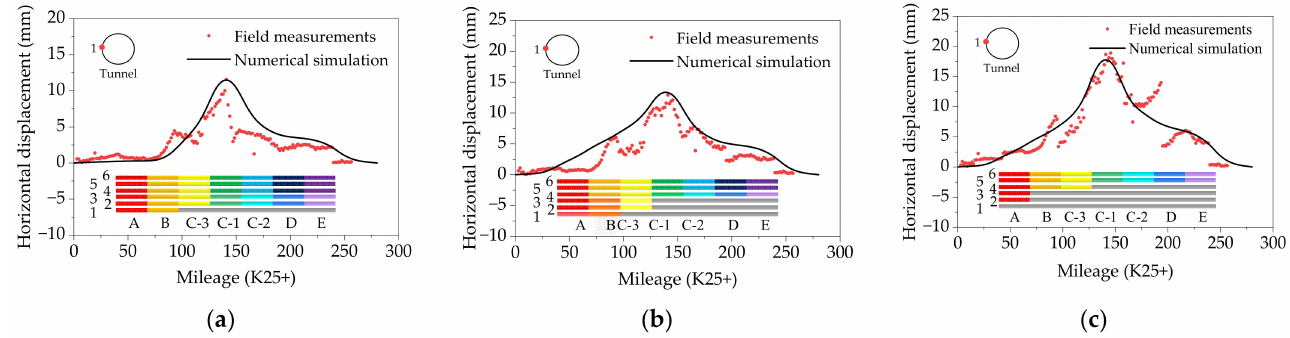
Figure 6. Grouting-induced horizontal tunnel displacement. ( a ) Stage 2; ( b ) Stage 3; ( c ) Stage